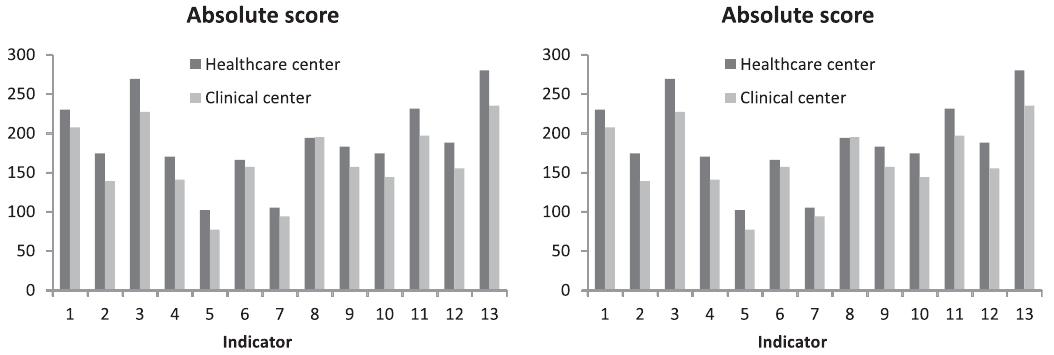
FIGURE 2. Absolute and relative score comparison of the distribution of scores across the thirteen indicators for the two health- care